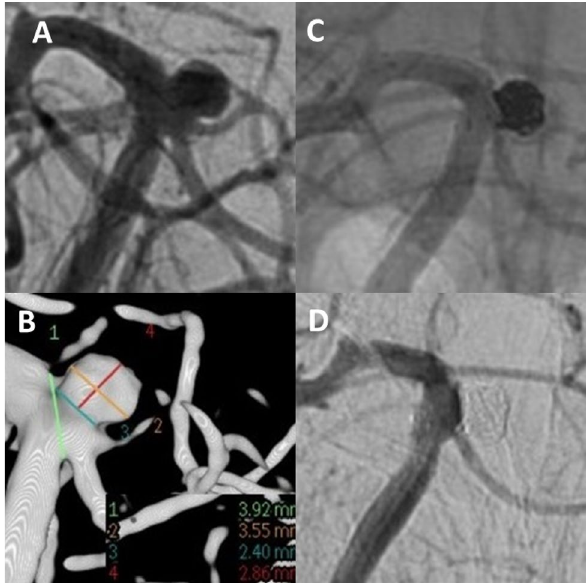
Figure 2. Unruptured aneurysm at the basilar tip ( A + B ). Stent-assisted coiling was intended. A stent (barrel-3550) with a barrel-shaped central segment was inserted to bridge the aneurysm neck in such a way that both the aneurysm base and the doubled superior cerebellar artery on the left are secured. The aneurysm sac is then probed through the stent mesh with a SL10-MC and closed with a total of 6 platinum micro-spirals. ( C ) Two-years angiographic control shows complete aneurysm occlusion ( D ).